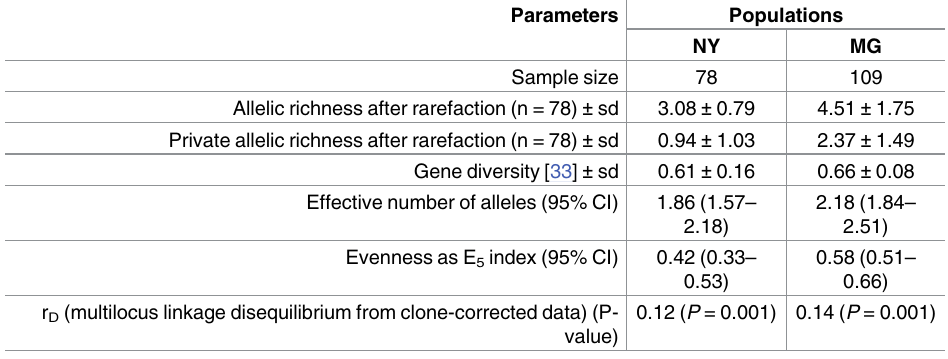
Table 2. Population genetic parameters of Sclerotinia sclerotiorum populations from New York (NY), USA and Minas Gerais State (MG), Brazil. Sd. = standarddeviationand 95% CI = 95% confidenceinterval.